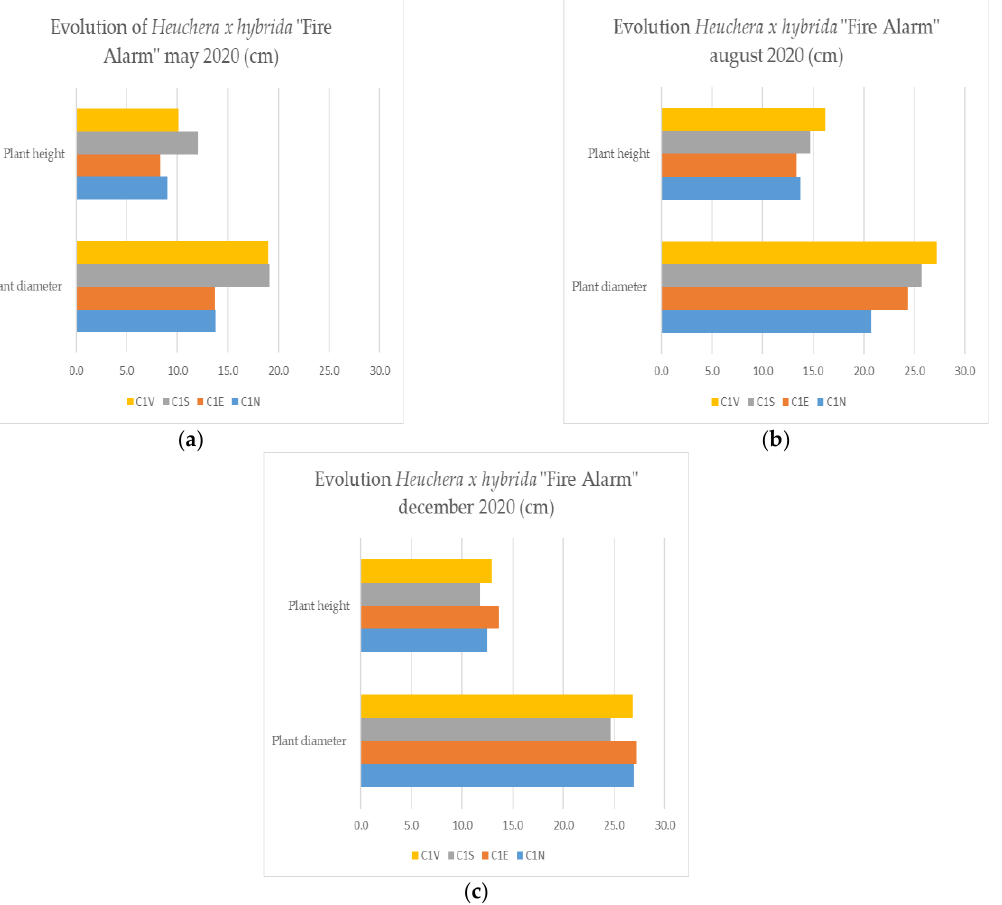
Figure 17. Evolution of height and diameter at Heuchera x hybrida ‘Fire Alarm’, May–December 2020 on cardinal orientations: ( a ) May; ( b ) August; and ( c ) December. The number of leaves in May reached the highest value on the southern